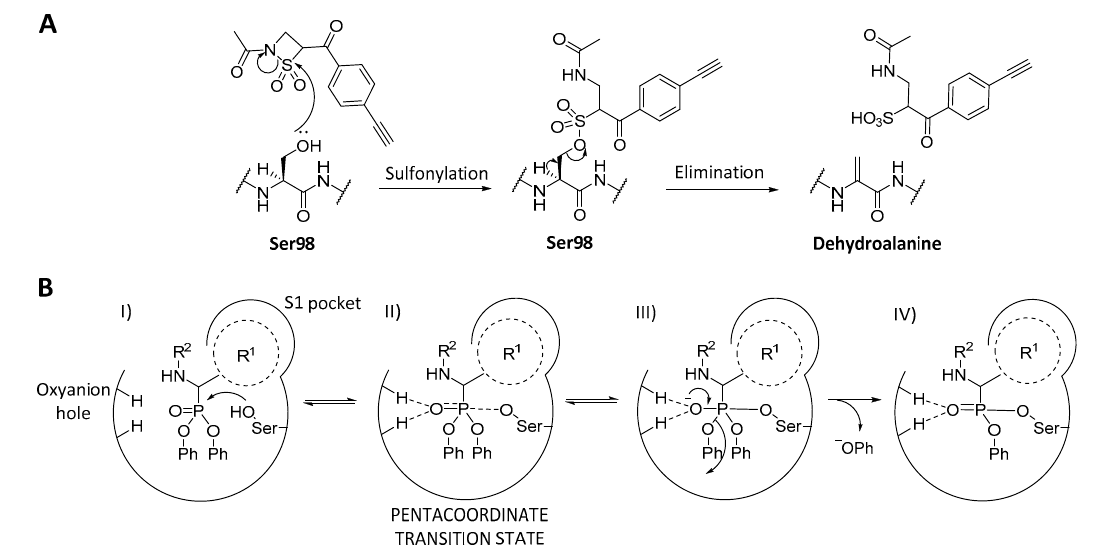
Figure 8. ( A ) Mechanism of action of RKS07 [102], a β -sultam undergoing sulfonylation and subsequent elimination to transform the catalytic serine into an inactive dehydroalanine. ( B ) Inhibitory mechanism of a diphenyl phosphonate inhibitor with a serine protease. I) The unreacted inhibitor enters the active site, with the R 1 moiety filling the S1 (recognition) pocket while the phosphonate stays at a reachable distance from the catalytic serine and the oxyanion hole. II) Nucleophilic attack of the serine to the phosphonate induced by the interaction with the oxyanion hole residues, forming the pentacoordinate transition state. III) Release of the phenolate group due to the recovery of tetrahedral geometry. IV) Final configuration leading to irreversible inhibition of the serine protease.